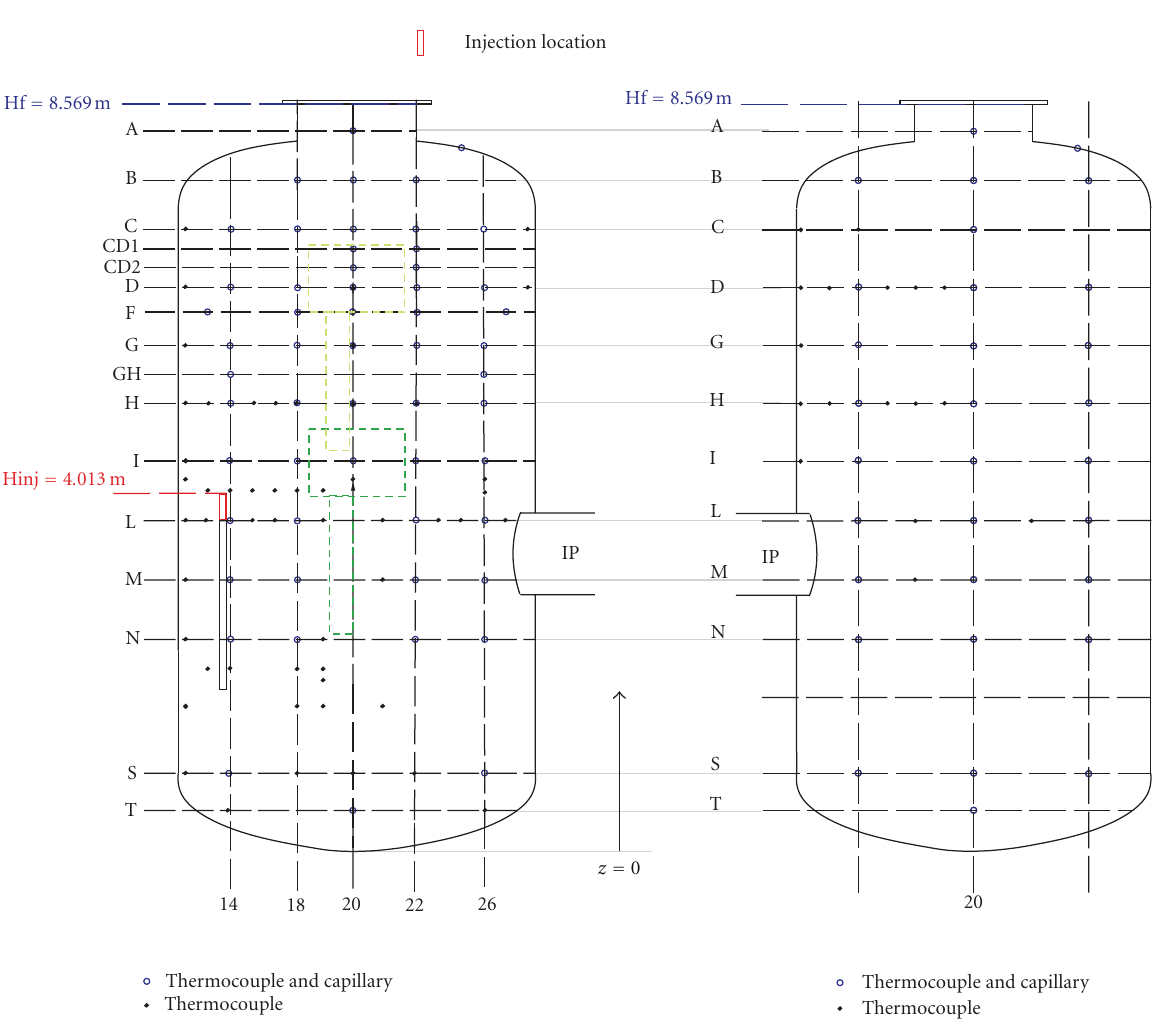
Figure 4: Sensor locations for mass spectrometer sampling lines and temperatures in the main measurement plane of Vessel 1 and Vessel 2 and cooler locations (middle and top